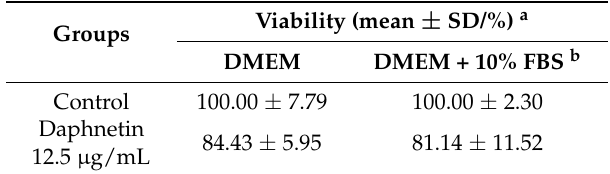
Table 3. The cytotoxic effects of daphnetin to GES-1 cells in medium (with/without